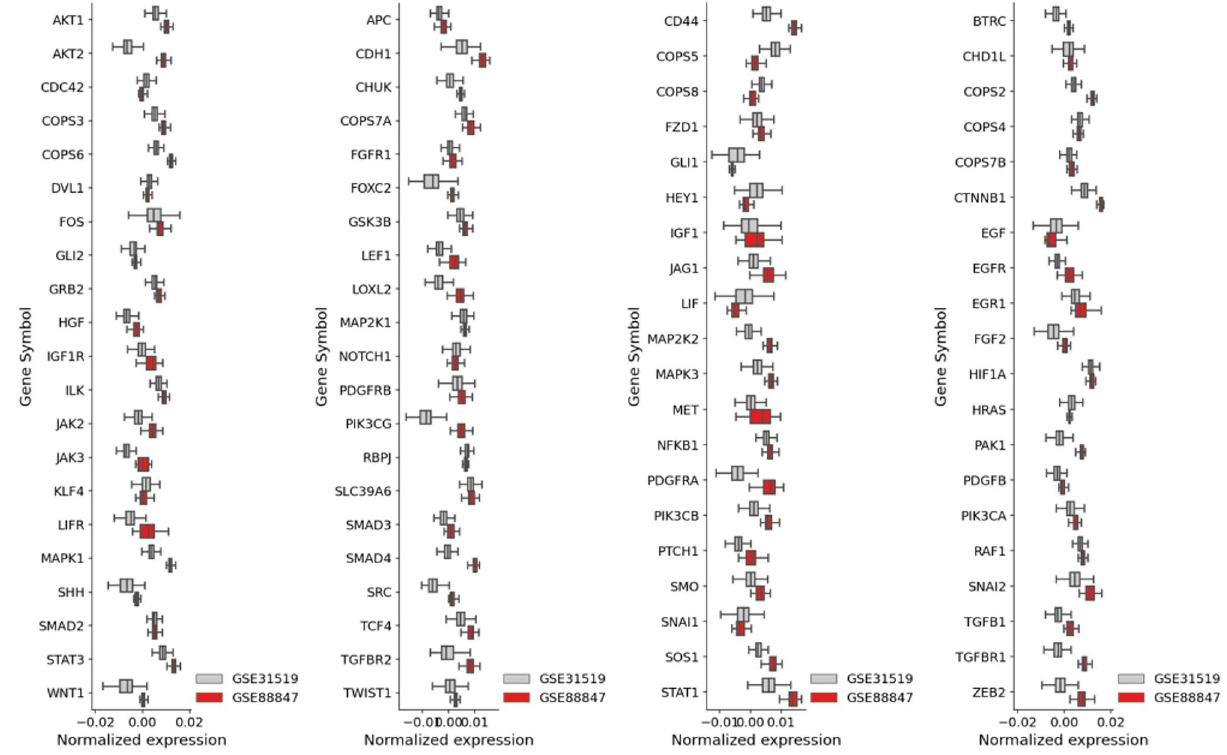
Figure 1. Data normalization is consistent across datasets. Boxplot of normalized expression for genes used as part of the ARIADNE score computation, comparing the dataset used to train ARIADNE (GSE31519) in 17 and the dataset analysed in this manuscript